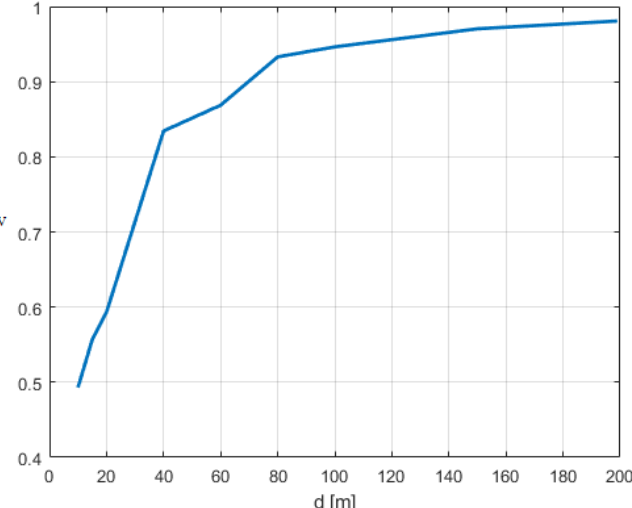
Figure 16. Ratio between the maximum voltage induced on the line considering or not considering the presence of a building. (A) H = 20 m, and d varies from 5 to 200 m. A finite ground conductivity of 1 mS/m is